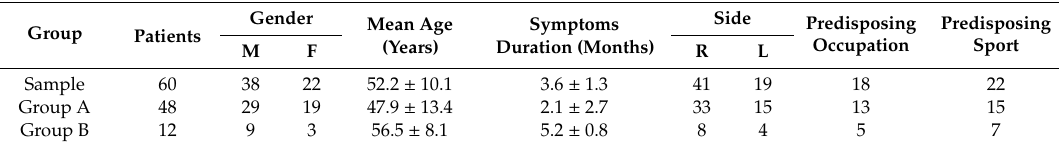
Table 1. Groups’ demographics. M = male; F = female; R = Right; L =